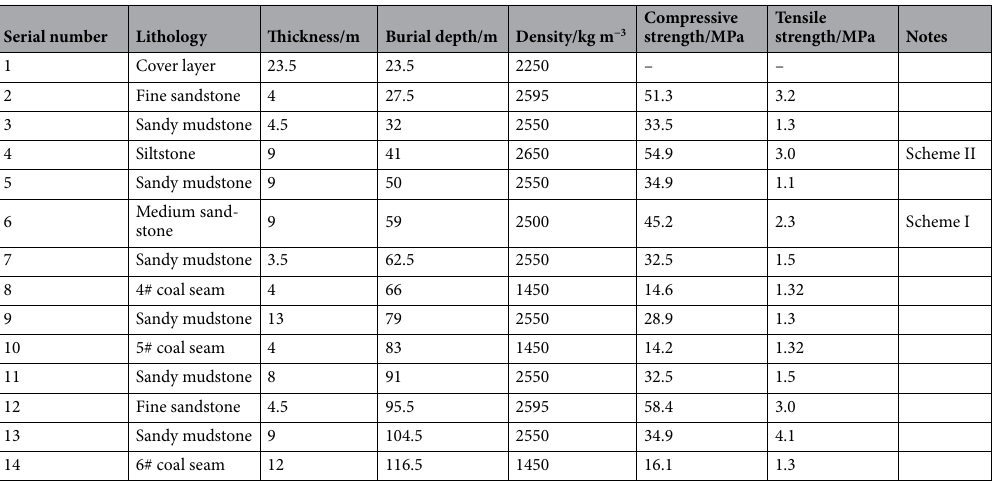
Table 2. Physical and mechanical parameters of each